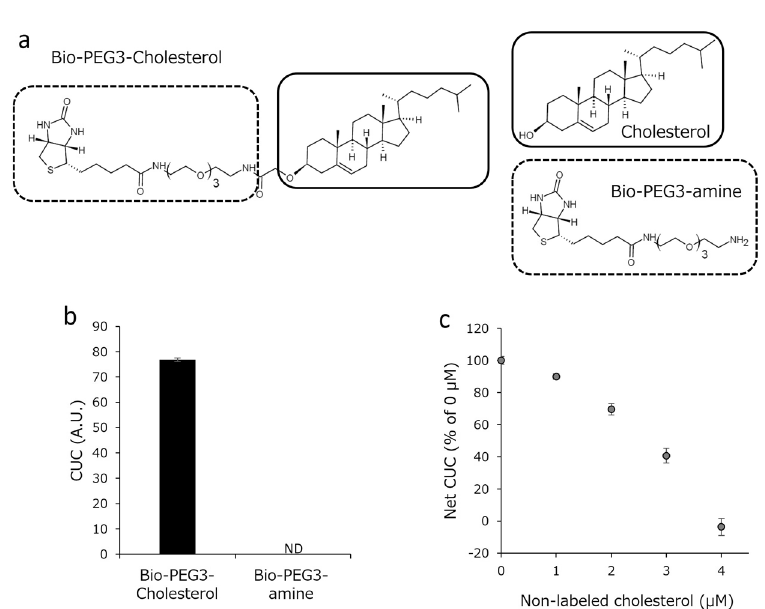
Figure 2. Essential role of the cholesterol structure of Bio-PEG3-cholesterol in its uptake by HDL. ( a ) Structural formulas of Bio-PEG3-cholesterol, free cholesterol, and Bio–PEG3 amine. ( b ) CUC was measured with serum in the presence or absence of Bio-PEG3 amine. ( c ) Serum was incubated with 0.5 μmol/L Bio- PEG3-cholesterol in the presence of an increasing concentration of cholesterol, then CUC was measured with or without pooled serum sample. Net CUC values were calculated by subtracting the background from the total count. All values represent the mean of triplicate determinations; error bars indicate SD. A.U. arbitrary